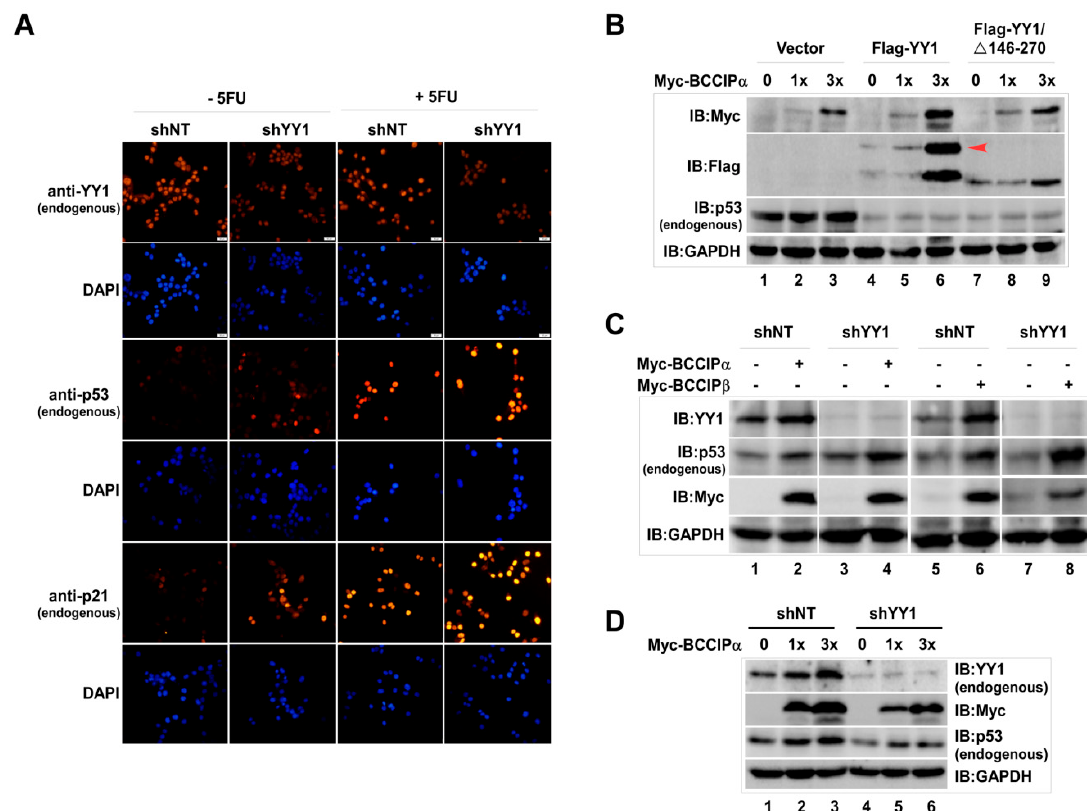
Figure 2. Stabilization of p53 by BCCIP was impacted by YY1 in HCT116 (p53 +/+ ) cells. ( A ) Negative regulation of p53 on YY1. Cells were transiently transfected with shYY1 (12 µ g / 10 cm culture plate) and a shNT control for 72 h. Then, endogenous YY1, p53, and p21 proteins were immune-stained by indicated antibodies. Scale bar indicates 200 µ m. ( B ) Impact of Flag-YY1 on p53-stabilization by BCCIP. Cells were co-transfected with Myc-BCCIP α (1.5 and 4.5 µ g) and Flag-YY1 (2 µ g) or deletion mutant Flag-YY1 / ∆ 146-270 (0.4 µ g) for 48 h. Indicated proteins were analyzed by western blot with specific antibodies. ( C ) Impact of shYY1 on p53 stabilization by BCCIP. The experiments were designed as shown. Whole cell lysate was prepared and endogenous p53 protein levels were detected 72 h after shYY1 transfection using anti-p53 antibody. ( D ) Endogenous p53 protein levels in stably expressing shYY1 cells. Endogenous p53 protein was measured at 72 h after transfection with BCCIP α in stably expressing shYY1 cells.